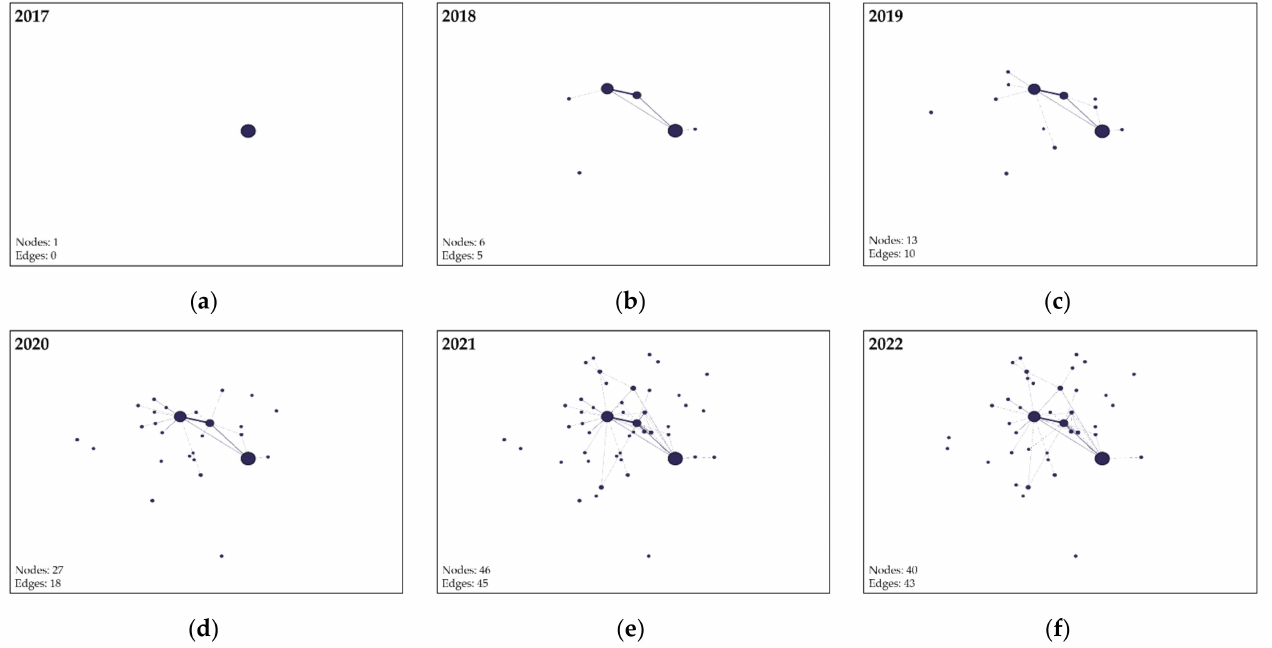
Figure 8. Dynamic representation of the regional bioeconomy network: ( a ) regional bioeconomy network in 2017; ( b ) regional bioeconomy network in 2018; ( c ) regional bioeconomy network in 2019; ( d ) regional bioeconomy network in 2020; ( e ) regional bioeconomy network in 2021; ( f ) regional bioeconomy network in